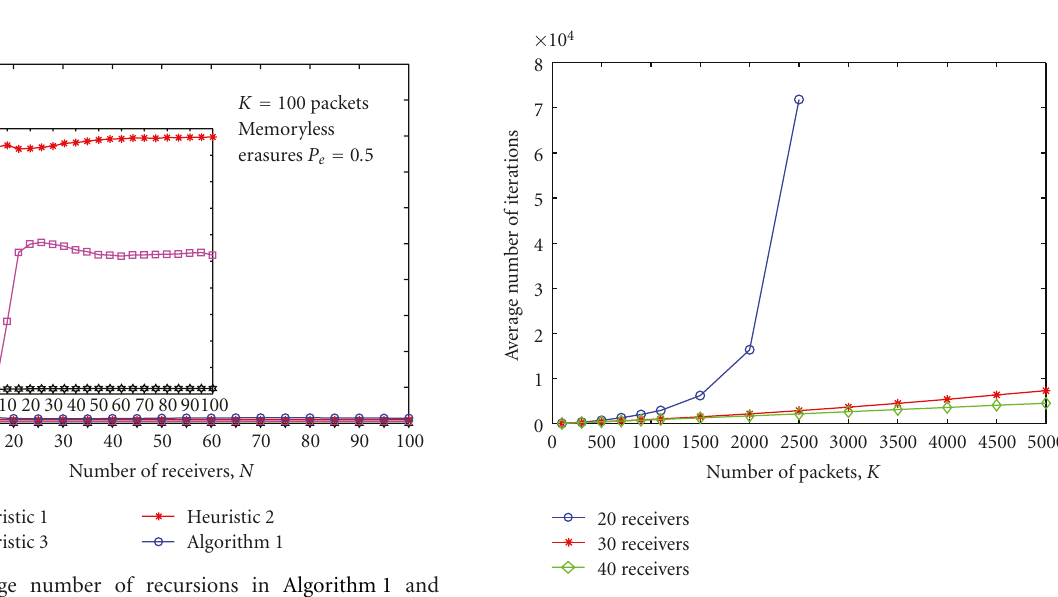
Figure 6: The e ff ect of increasing the number of packets on the computational complexity of Algorithm 1 in terms of number of recursions. The complexity remains linear with the number of packets for well-sized receiver populations (30 and 40